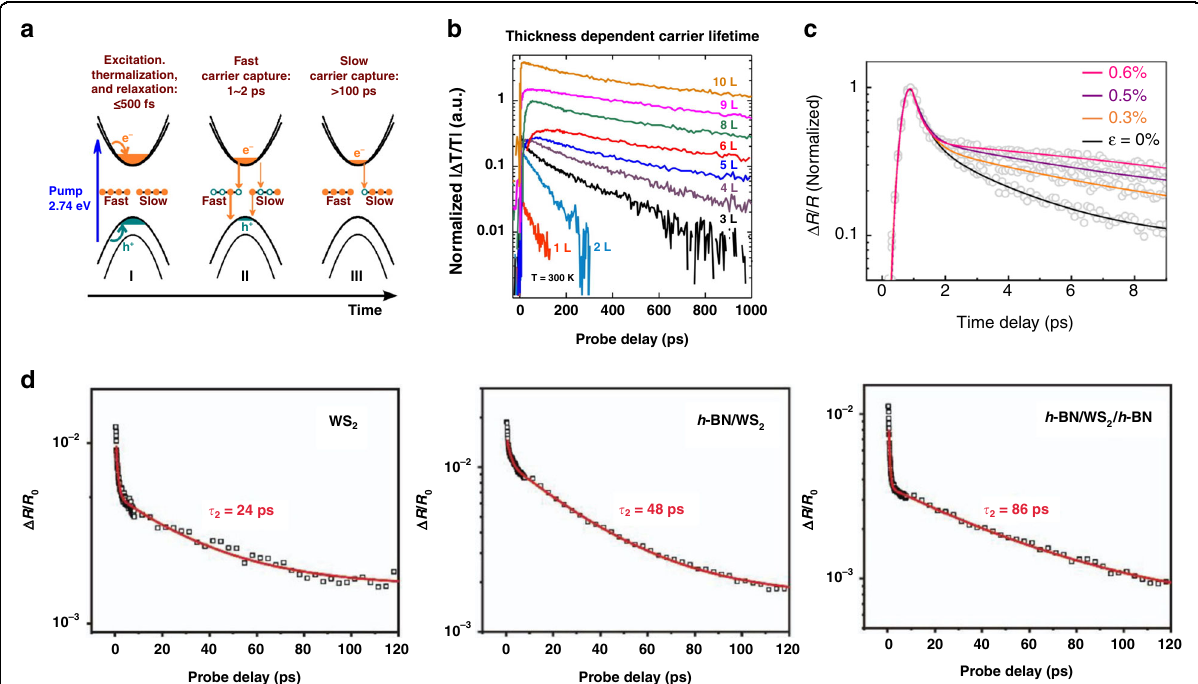
Fig. 5 Defect-assisted photocarrier relaxation. a Illustration of the ultrafast carrier dynamics in MoS 2 mediated by defect-assisted Auger recombination with two different deep mid-gap defect levels. b Differential transmission transients ( Δ T / T ) of MoS 2 with different numbers of layers. c Strain-dependent transient absorption spectra of a MoS 2 monolayer. d Differential re fl ection signal measured from WS 2 , h BN/WS 2 , and h BN/WS 2 / h BN regions over long-time ranges. Figure reproduced with permission from a ref. 65 , © 2015, American Chemical Society; b ref. 66 , © 2015 American Chemical Society; c ref. 75 , © 2020 Chinese Physical Society and IOP Publishing Ltd; d ref. 42 , © 2019 WILEY ‐ VCH Verlag GmbH & Co. KGaA,